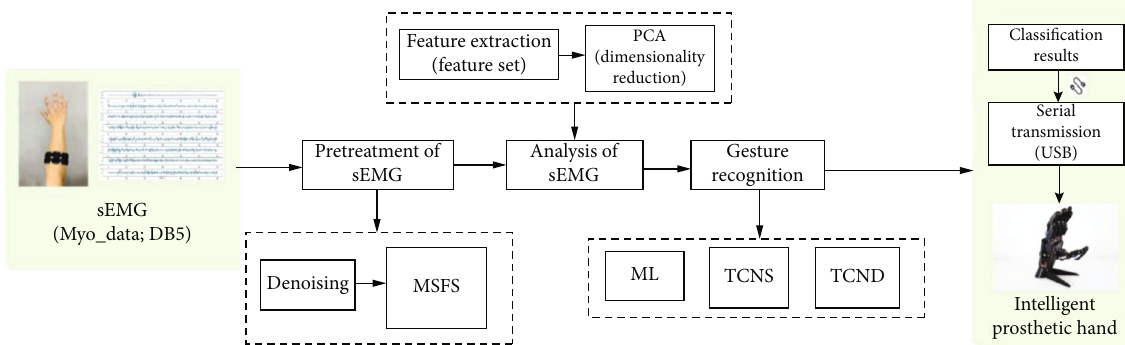
Figure 1: The scheme of the entire process.